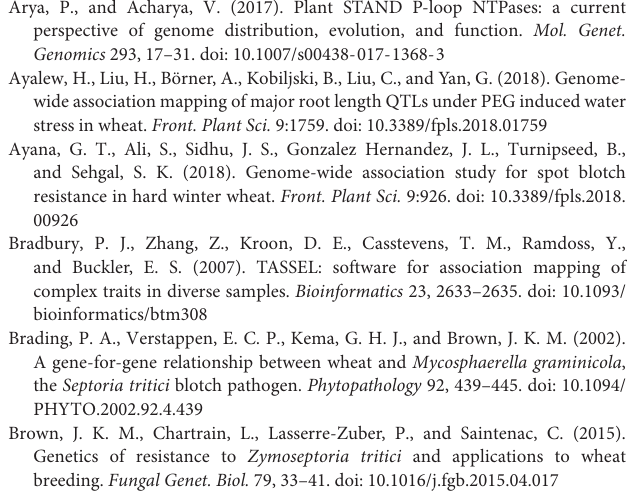
Supplementary Figure 2 | Quantile–Quantile (Q-Q) plots of marker–trait association at the adult plant stage (APS) at Sidi Allal Tazi during 2017 (SAT-17), 2018 (SAT-18), and at Marchouch during 2017 (MCH-17) using GLM + Q model (A) , GLM + PCA model (B) , MLM + Q + K model (C) , and MLM + PCA + K